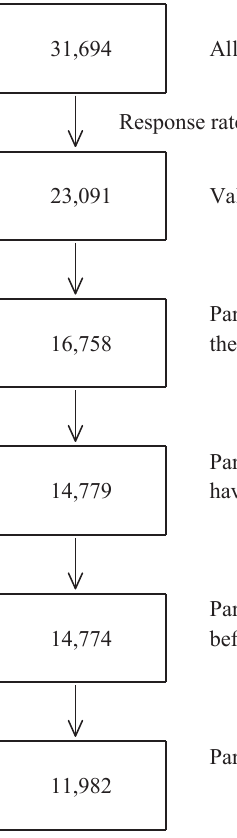
Figure 1. Flowchart of study